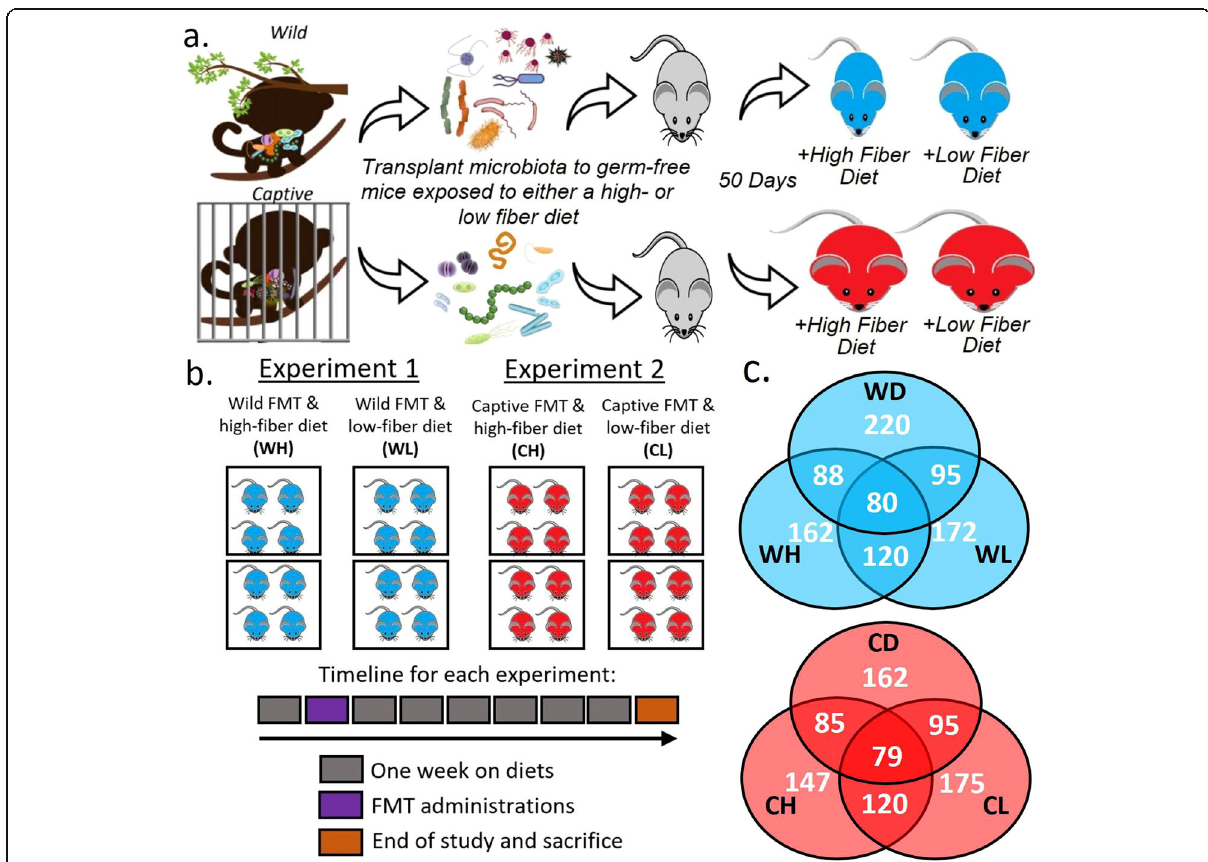
Fig. 1 Overview of experimental design ( a ), experimental setup ( b ), and microbiota transfer efficacy ( c ). Germ-free mice were gavaged with either a donor pool FMT from wild (indicated in blue) or captive (indicated in red) doucs and fed a high- or low-fiber diet. Each pair of square boxes indicates a single isolator with four male and four female germ-free mice for a total of four isolators. Reported in ( c ) are total species and overlapping species recovered from fecal samples collected on day 49 prior to sacrifice, as well as from the Wild and Captive FMT donor pools. Abbreviations: Captive High (CH), Captive Low (CL), Wild High (WH), Wild Low (WL), Wild FMT Donor pool (WD), Captive FMT Donor pool